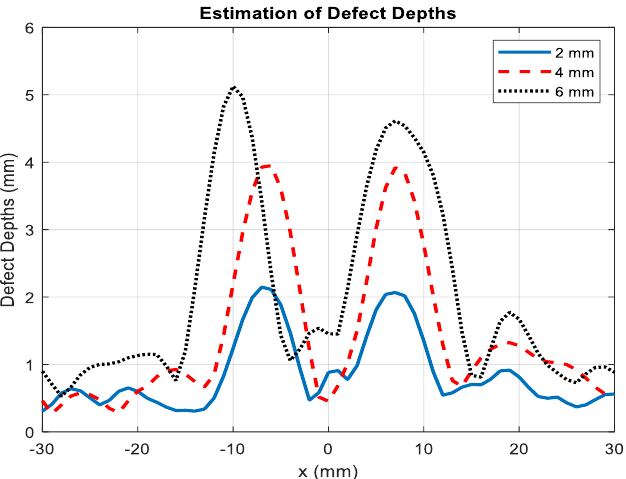
Figure 6. Thickness estimation of defects with 𝐻 𝐷 of 2 mm, 4 mm, and 6 mm with 𝑊 𝐷 = 2 mm with a smaller sensor.